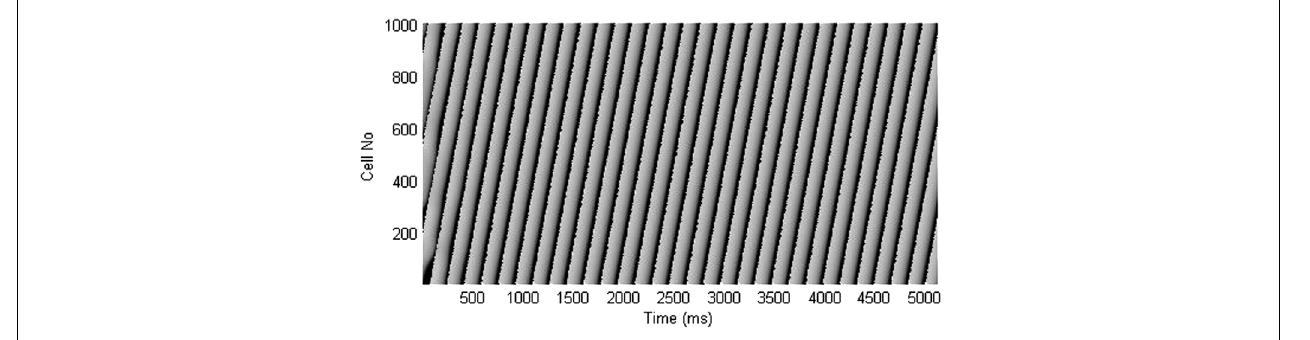
FIGUREA2 |Time-space plot shows that block of I to current lengthens the shortAPD and shortens the longAPD, resulting in termination ofAPD alternans.